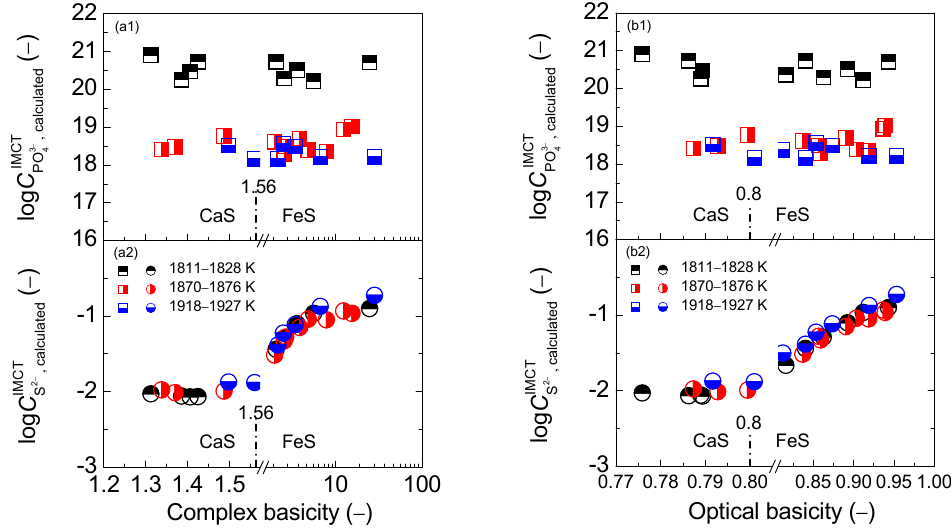
Figure 8. Relationship of simplified complex basicity ( % CaO ) / [( % P 2 O 5 ) + ( % Al 2 O 3 )] ( a ) or optical basicity Λ ( b ) against the calculated [3] phosphate capacity log C IMCT model in first layer or calculated [5] sulfide capacity log C IMCT model in second layer for CaO–FeO–Fe 2 O 3 –Al 2 O 3 –P 2 O 5 slags equilibrated with liquid iron over a temperature range of 1811 to 1927 K (1538 to 1654 °C), respectively.